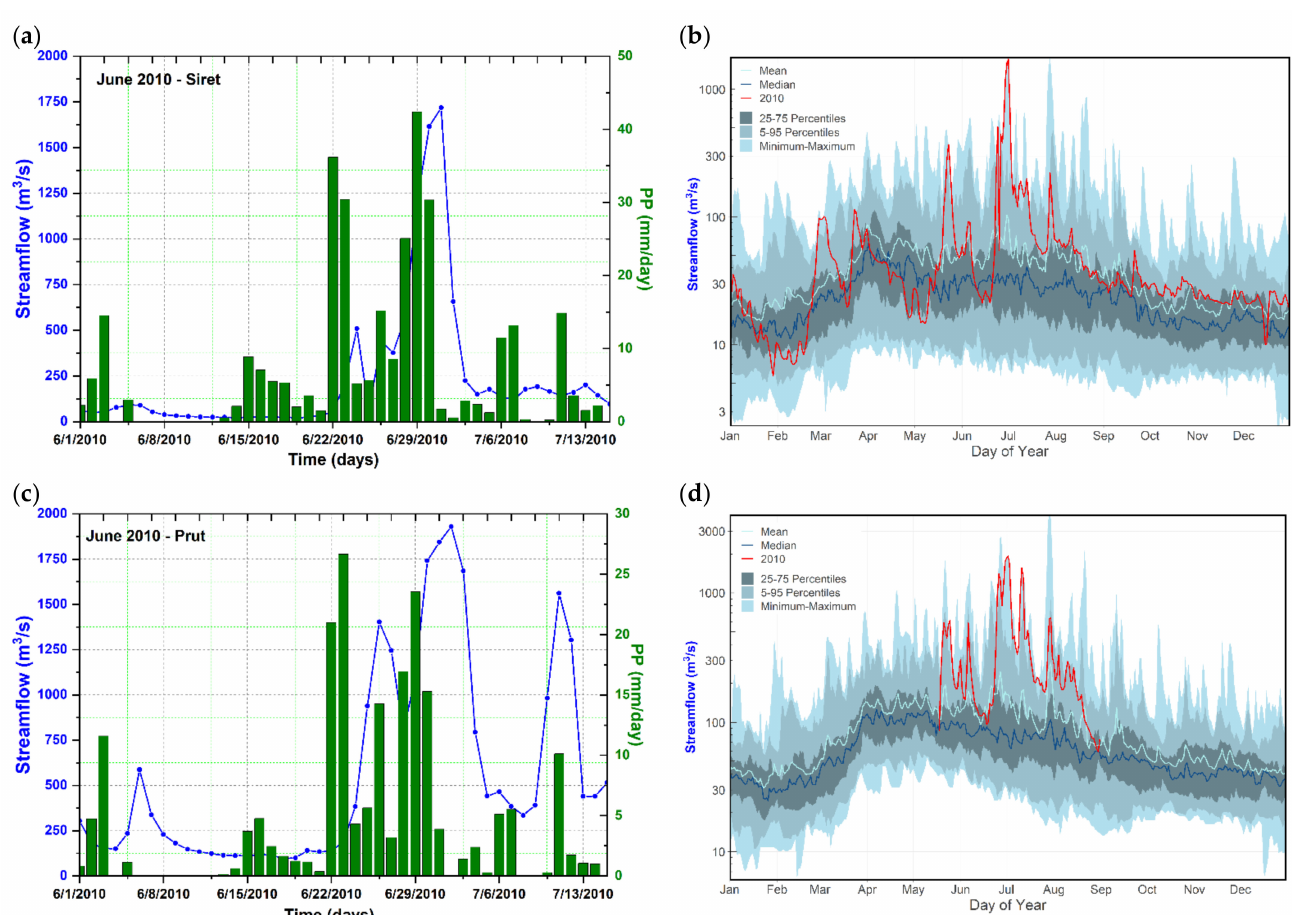
Figure 7. ( a ) Daily streamflow at Lespezi gauging station situated on the Siret River (blue line) and the precipitation amount at R ă d ă ut i meteorological station (green bars) for the period 1 June–15 July 2010; ( b ) The evolution of the flood peak in , June 2010 (red line) at Lespezi gauging station compared to the daily streamflow pattern on an annual basis (blue shaded line); ( c ) Daily streamflow at R ă d ă ut i-Prut gauging station situated on the Prut River (blue line) and the daily precipitation , amount at Darabani meteorological station (green bars) for the period 1 June–15 July 2010; ( d ) The evolution of the flood peak in June 2010 (red line) at R ă d ă ut i-Prut gauging station compared to the daily streamflow pattern on an annual basis , (blue shaded area). For the location of the gauging and meteorological stations, see Figure 1. The period 1981–2000 was used to compute the daily streamflow climatology in ( b , d ). For R ă d ă ut i-Prut gauging station streamflow data was available , just for the period 18 May–31 August